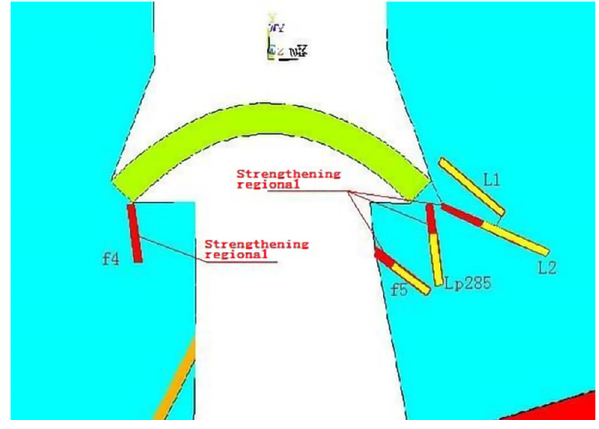
Figure 16: Schematic diagram of the reinforcement part.